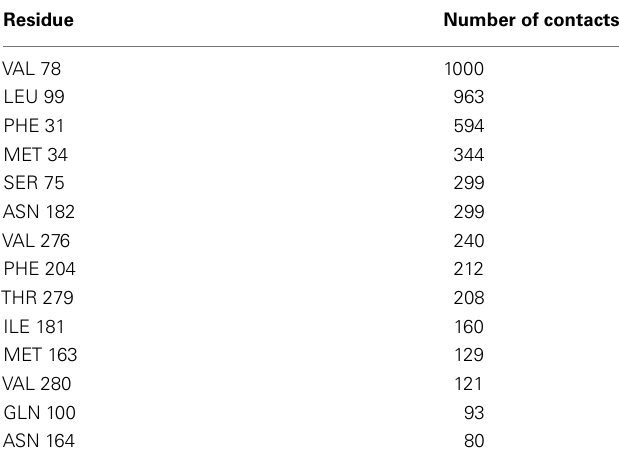
Table 1 | Number of times a side-chain atom from the listed residue has been the minimum-distance from the carbonyl oxygen of isoamyl acetate, as compared to all other receptor atoms, during the